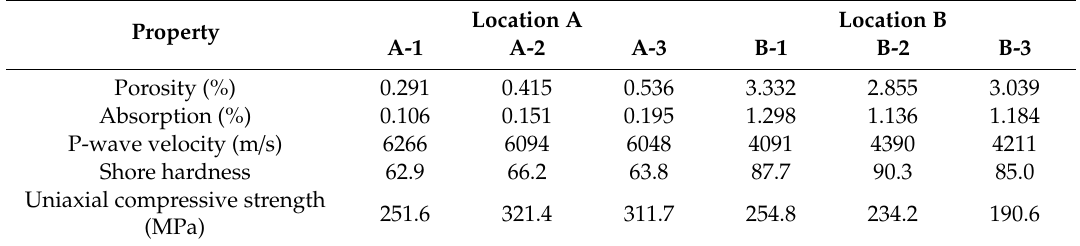
Figure 6. Photographs of measurement systems of rock properties: ( a ) Uniaxial compressive strength; ( b ) shore hardness; ( c ) absorption; ( d ) P-wave velocity. Table 2. Range of rock properties of the pre-test sample specimens.